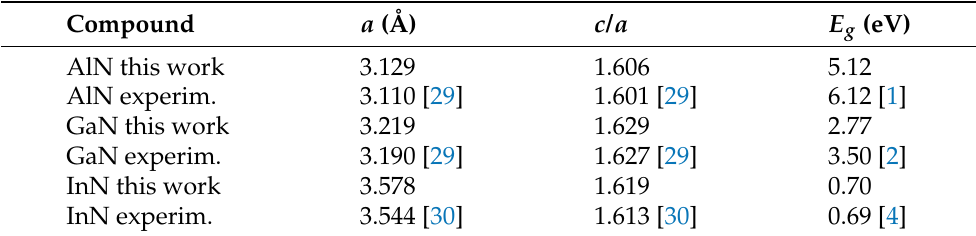
Table 1. Hexagonal lattice parameters a and c/a ratios (GGA), and band gaps (MBJGGA) calculated in this work, and available experimental data for wurtzite group III